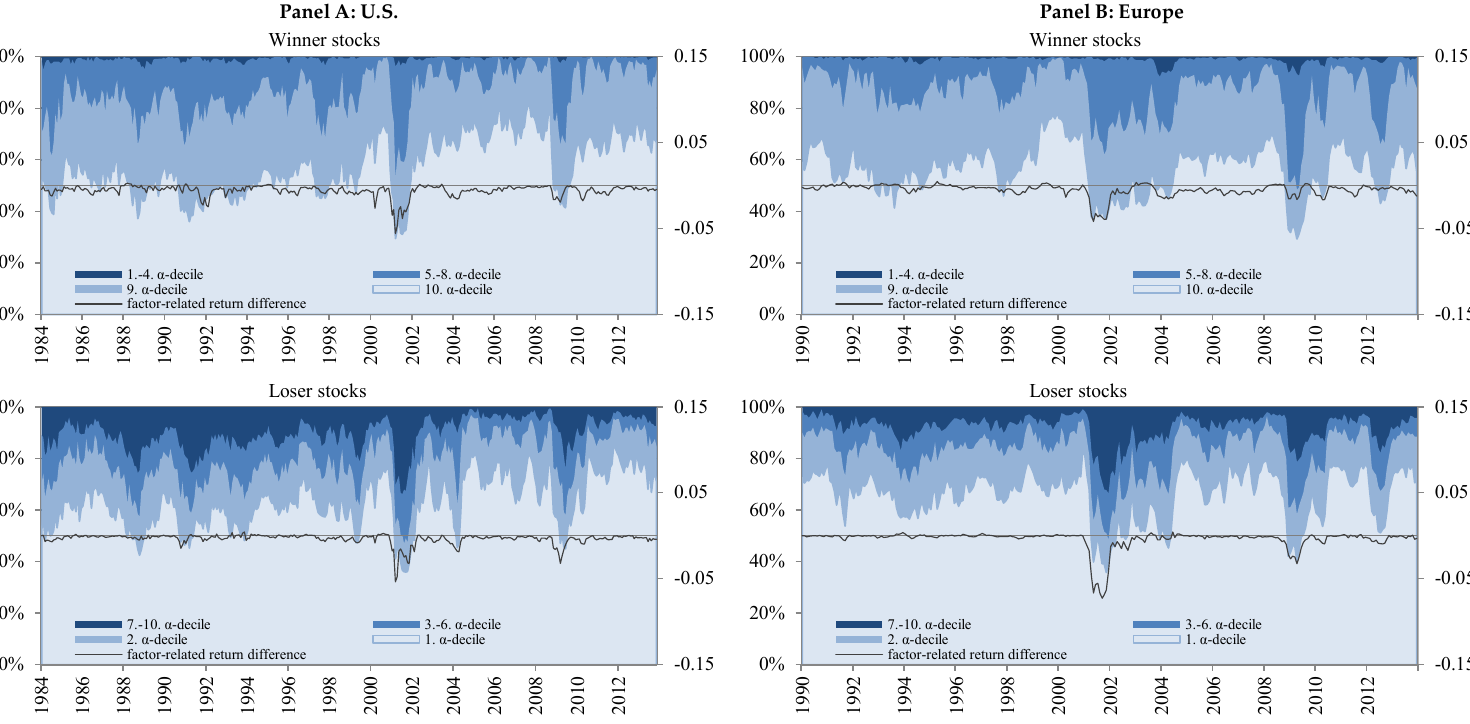
Figure 1. This figure shows the overlap between stocks according to price momentum and alpha momentum for a twelve-month formation period and a one-month investment period. The shaded areas show the percentage of price momentum winner (loser) stocks in the respective alpha momentum deciles (left scale). For instance, the “10.α-decile” (“1.α-decile”) area shows the percentage of all price momentum winner (loser) stocks that are also alpha momentum winner (loser) stocks. Therefore, this area shows a time-dependent overlap between price momentum and alpha momentum stocks. The “9.α-decile” (“2.α-decile”) area presents the percentage of all price momentum winner (loser) stocks that are located in the ninth (second) decile when we rank by past alpha, and so on. The black line presents the negative absolute difference between the average monthly factor-related return contribution of alpha momentum and price momentum for winner (loser) stocks (right scale). Results are presented in Panel A for the U.S. from January 1984 to December 2013 and in Panel B for Europe from January 1990 to December 2013.